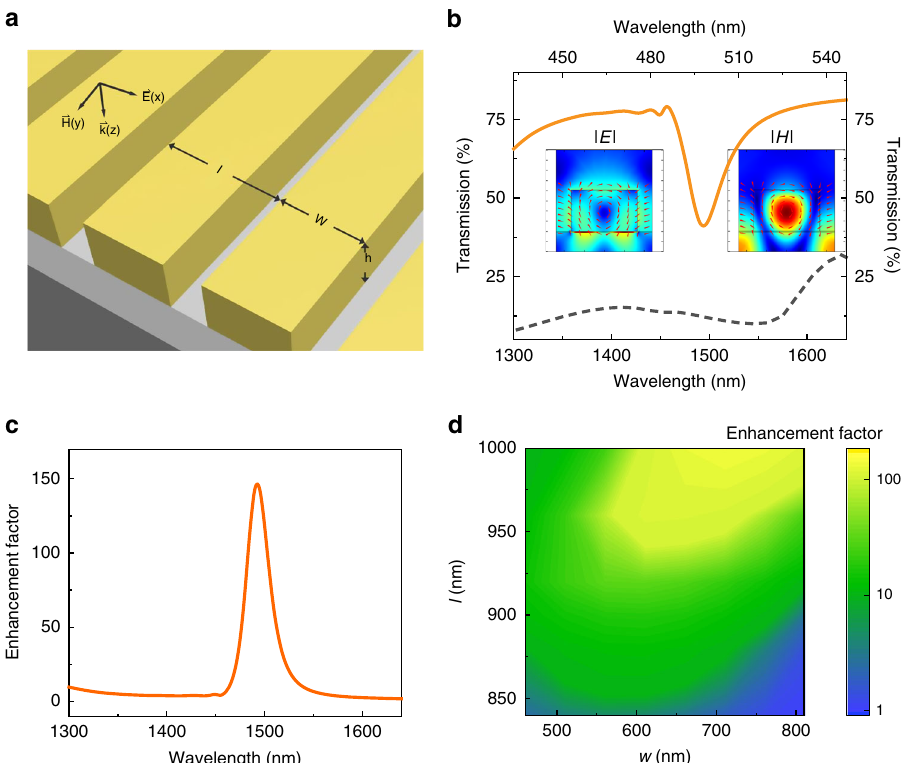
Fig. 2 The design of MAPbBr3 perovskite metasurfaces. a The schematic picture of perovskite metasurface. Here the thickness of fi lm is kept at h = 420 nm. The width of perovskite strip and the lattice sizes are w and l , respectively. b The numerically calculated transmission spectra of perovskite metasurface with l = 960 nm and w = 660 nm at the near infrared (solid line) and visible spectra (dashed line). The insets are the electric and magnetic fi eld distributions of resonant mode. c The enhancement factor of intensity in perovskite metasurface. The arrows show the directions of electric fi eld. d The enhancement factor of resonant modes at a function of l and